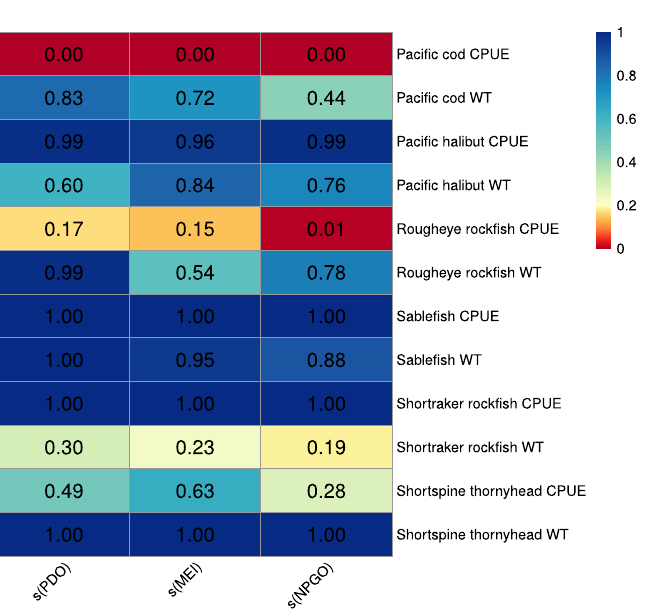
Figure 8. FDR-corrected P -values for relationship between selection of each environmental variable contributing to groundfish CPUEs or WTs each year and lagged seasonal amplitudes of climate indices PDO ( a ), MEI ( b ), and NPGO ( c ) fitted using logistic regression. Abbr: cod = Pacific cod; halibut = Pacific halibut; sable = sablefish; rrock = rougheye rockfish; srock = shortraker rockfish; thorny = shortspine thornyhead; CPUE = catch per unit effort; WT = mean weight in kg. P < 0.05 are indicated with red.